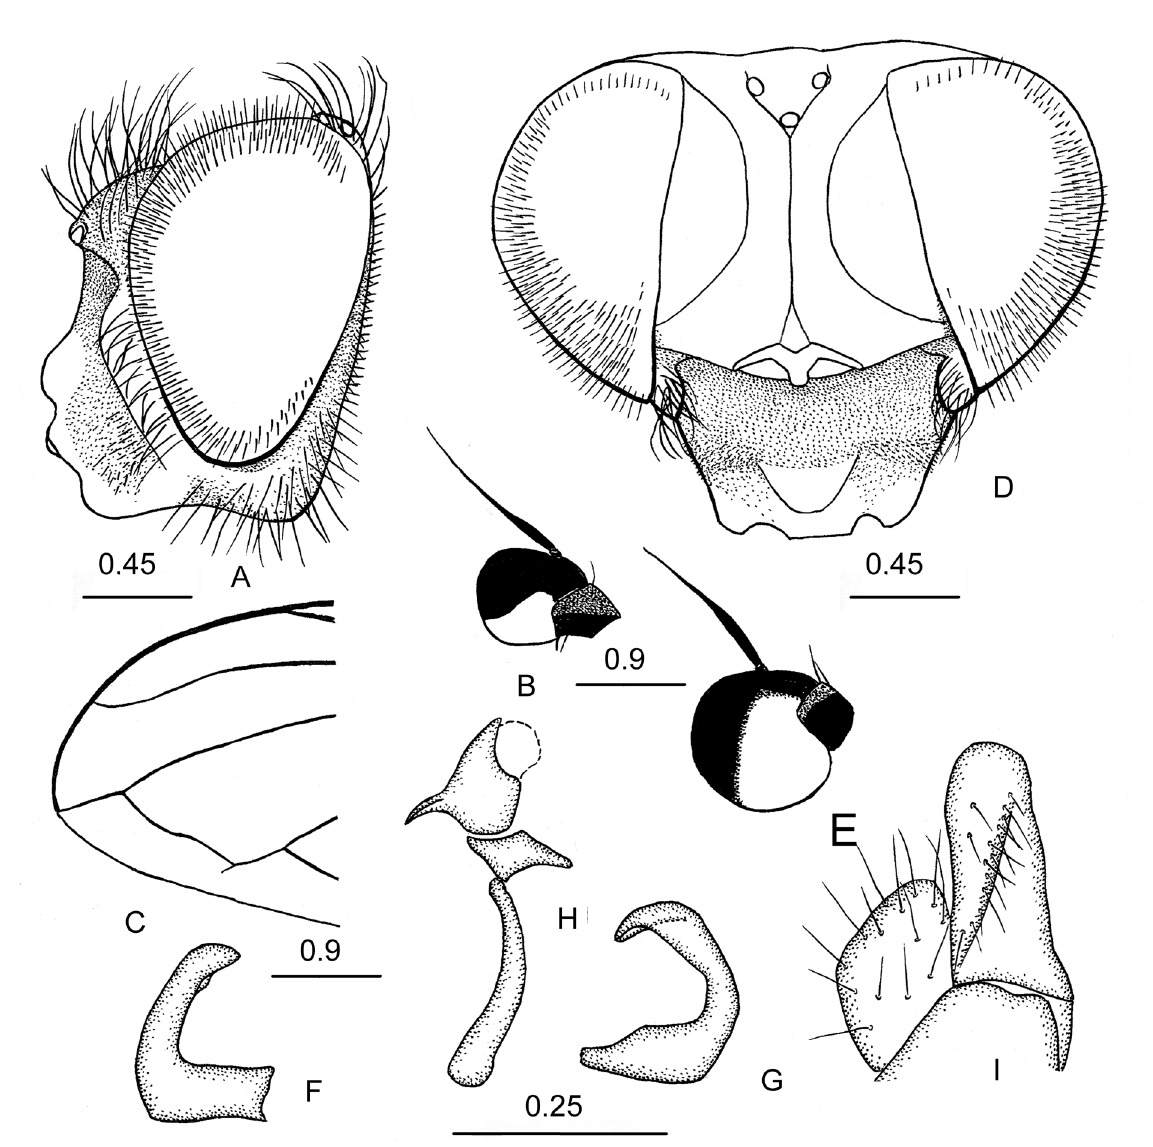
Fig. 41. Cheilosia ( Montanocheila ) minuscula sp. nov.; A–C, F–I = holotype, ♀ (CSCA), D–E = paratype, ♂ (CSCA). A . Head, lateral view. B, E . Antenna, lateral view of pedicel and basoflagellomere. C . Tip of wing. D . Head, dorsal view. F–G . Superior lobes of hypandrium, lateral view. H . Aedeagus and aedeagal apodeme, lateral view. I . Surstylus and gonocercus, lateral view. Scale bars indicated in